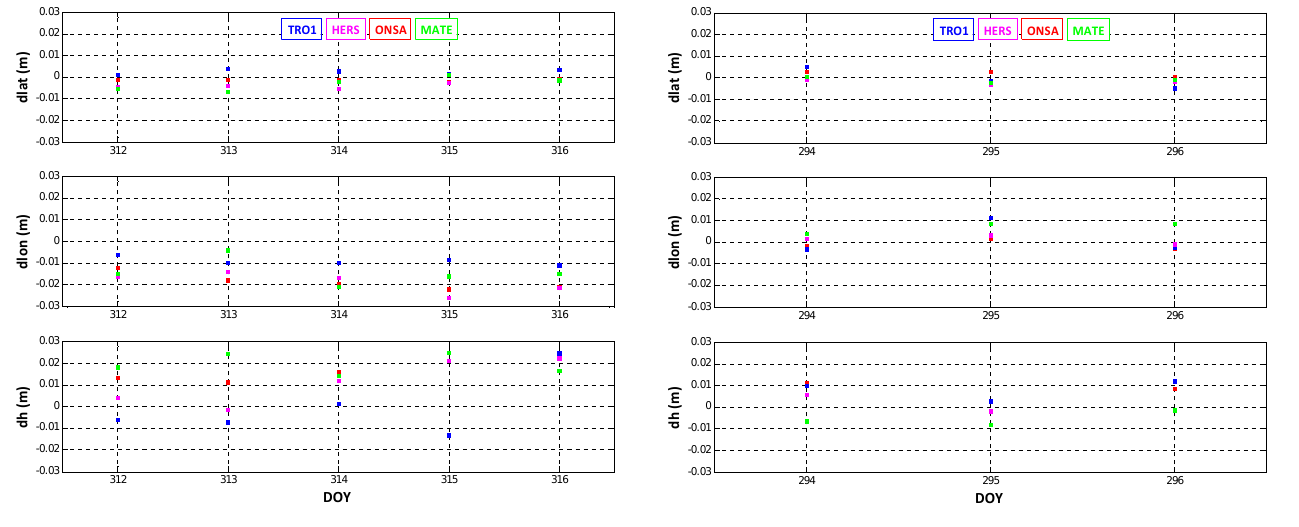
Fig. 14 . “Corrected – Uncorrected” PPP results for the geodetic coordinates of the stations on DOY 294‐296 in 2001. Fig. 15. “Corrected – Uncorrected” PPP results for the geodetic coordinates of the stations on DOY 312–316 in 2001.